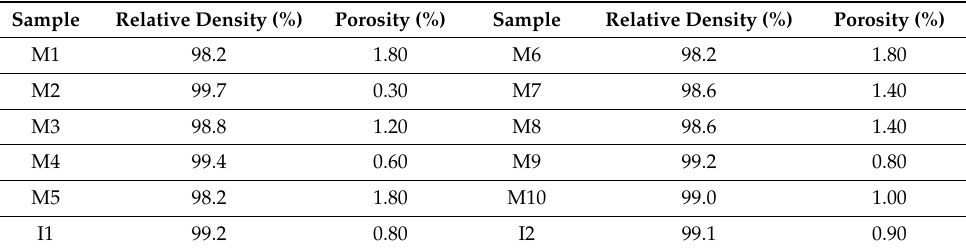
Table 1. Relative density and porosity percentage calculated for ten sintered Al-based nanocompo- site samples. M and I labels are used for the samples processed and sintered at the laboratory and industrial level, respectively.